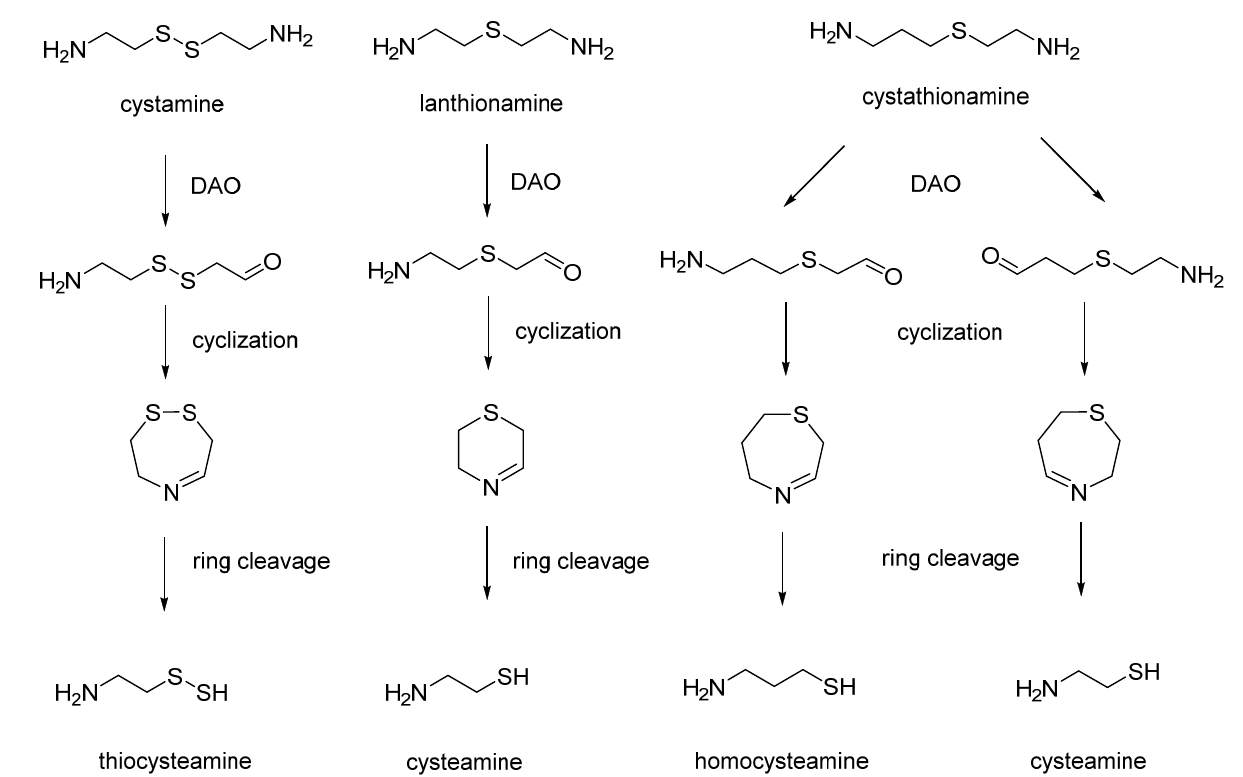
Figure 8. Oxidation of thiodiamines by diamino oxidase (DAO).